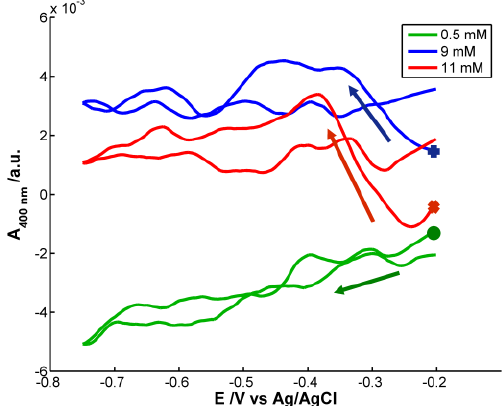
Figure 6. Voltabsorptogram at 400 nm registered during H O reduction on AgNPs-modified 2 2 SPE. (─) C = 5 × 10 −4 M, (─) C = 9 × 10 −3 M, (─) C = 1.1 × 10 −2 M. The H2O2 H2O2 H2O2 following symbols (  ,  ,  ) mark the first absorbance value in each voltabsorptogram. Arrows mark the direction of the reduction scan. Experimental conditions as in Figure